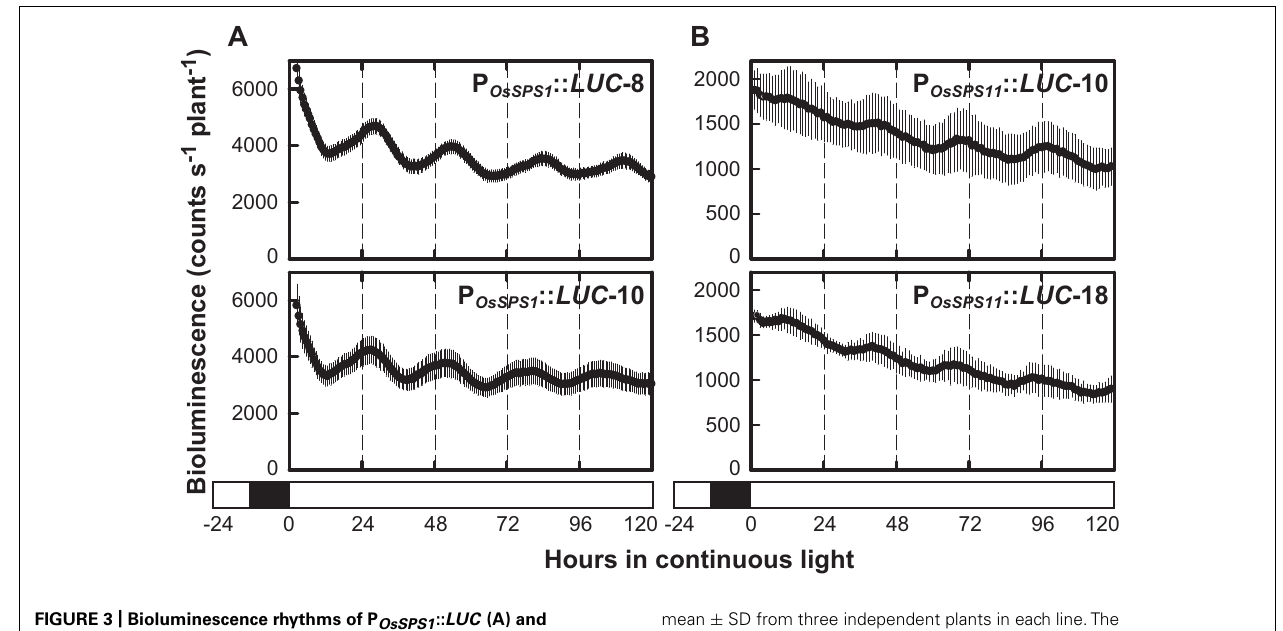
mean ± SD from three independent plants in each line.The results are summarized in Table 2 .We obtained essentially the same results from three independent experiments. White and black bars represent light and dark periods, respectively.